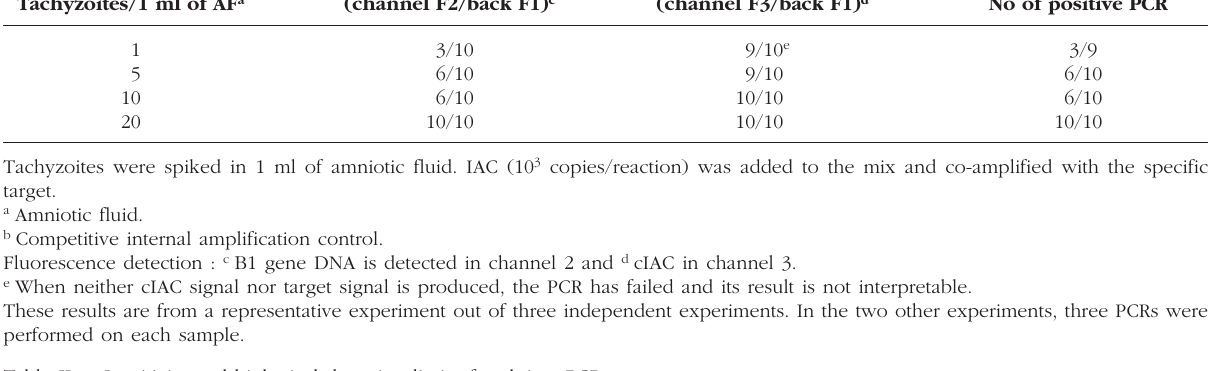
Table II. – Sensitivity and biological detection limit of real-time